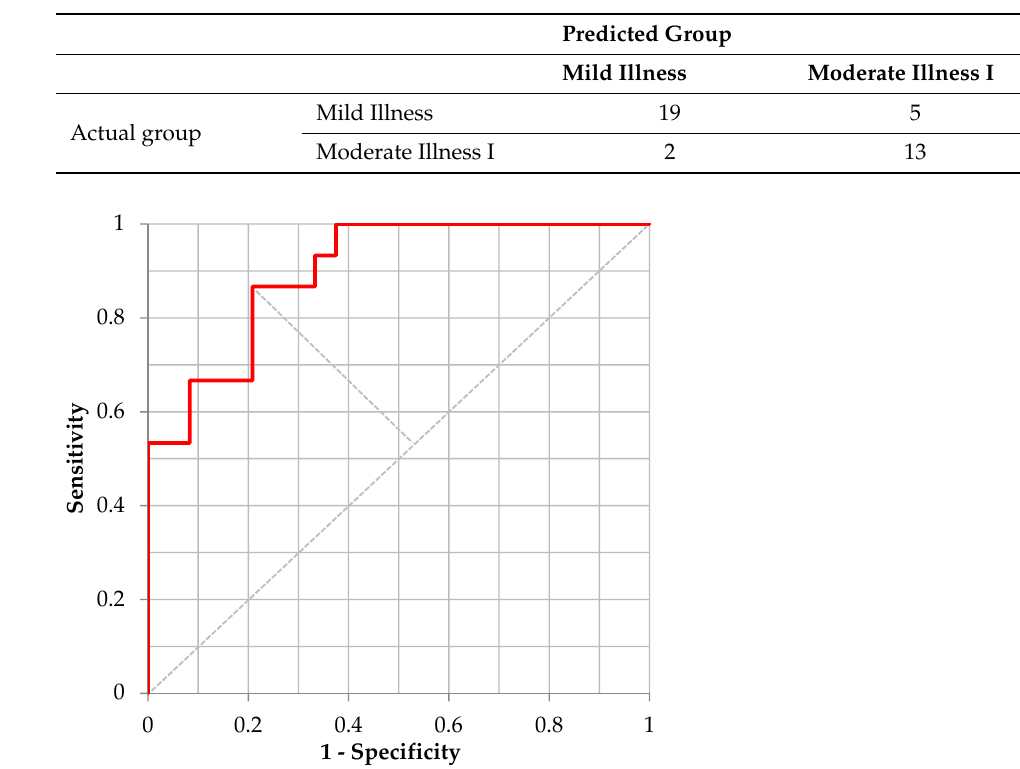
Figure 2. ROC curve distinguishing “Moderate Illness 1” using the learning model of /Eh/. Table 11. Confusion matrix of /Uh/. Table 11. Confusion matrix of /Uh/.